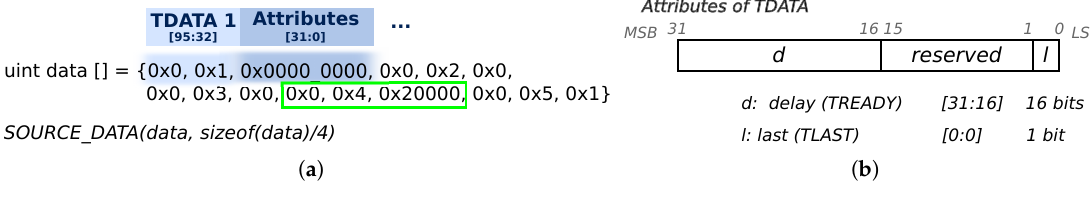
Figure 2. Data organization of source component. ( a ) High-level test function; ( b ) Attributes of TDATA